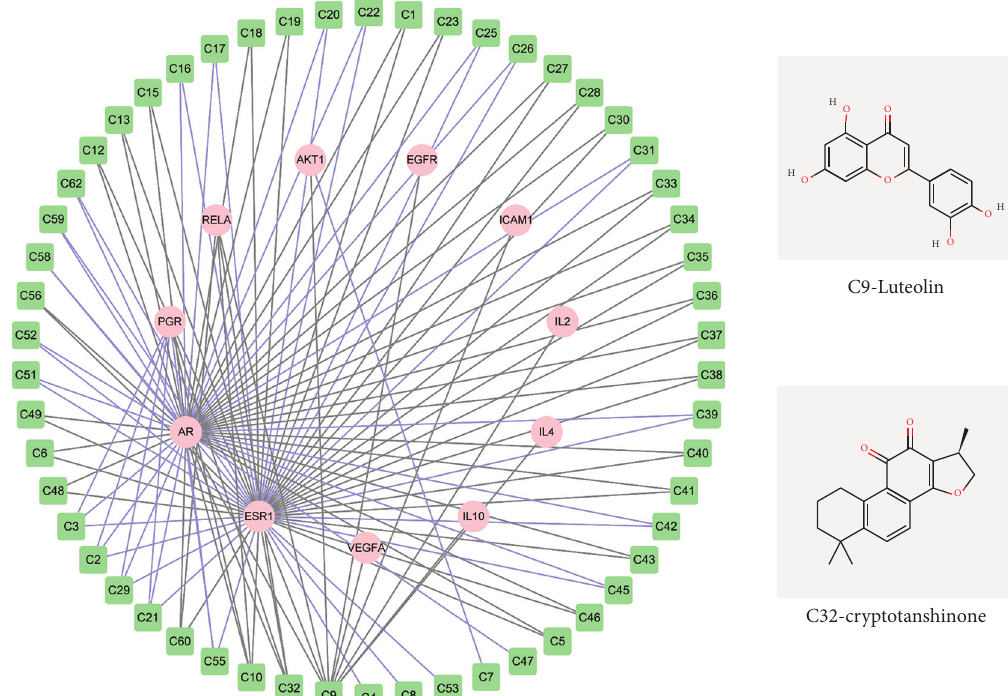
Figure 7: Key active compounds in Codonopsis pilosula .